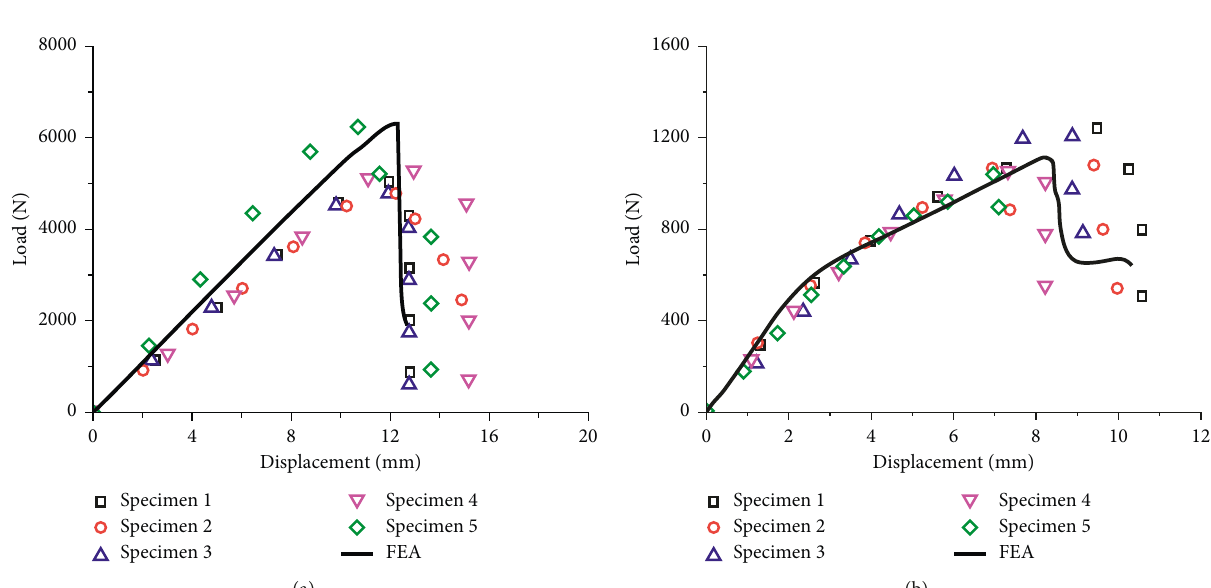
Figure 8: A comparison between numerical and experimental load-displacement relationship. (a) Longitudinal. (b)